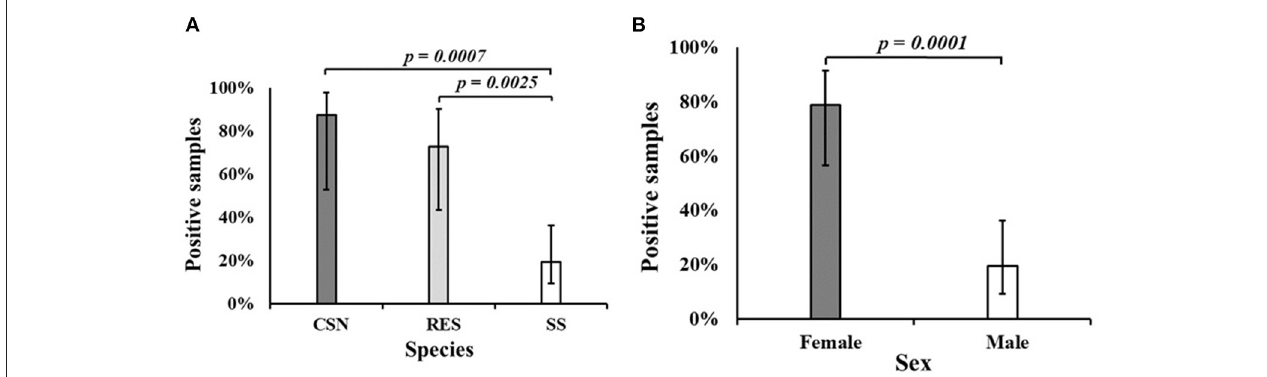
FIGURE 2 | The number of Salmonella enterica isolates of each serotype isolated from different turtle species. CSN, Chinese stripe-necked turtle ( Mauremys sinensis ); RES, Red-eared slider ( Trachemys scripta elegans ); SS, Chinese softshell turtle ( Pelodiscus sinensis ).